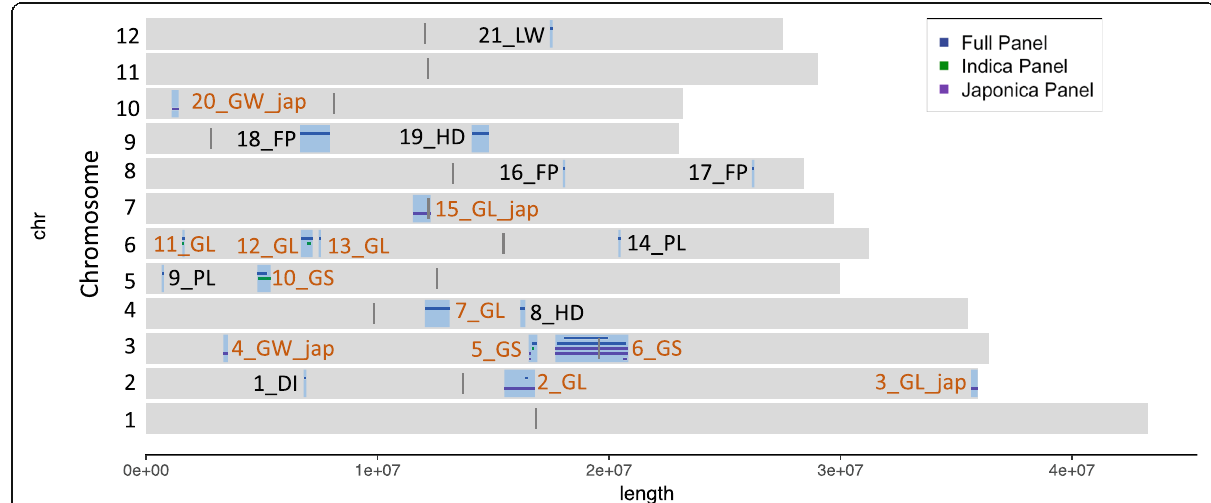
Fig. 5 The distribution of 21 QTL. 21 significant associations for 8 of the 13 traits ( − log 10 (p value) ≥ 8.0). The 33 individual associations for the full panel and the Japonica and Indica subpanels were merged to form the 21 final QTLs. The QTLs for grain length, grain width and grain length/ width ratio were merged into QTLs for grain size, these are labelled in brown. The remaining QTLs are labelled in black; Leaf width (LW), Panicle Length (PL), Heading Date (HD), Floret Pubescence (FP), Diameter Internode (DI). Regions smaller than 100 kb are extended to 50 kb either side of SNP with maximum p value. Centromeric regions are shown as 100 kb regions in dark